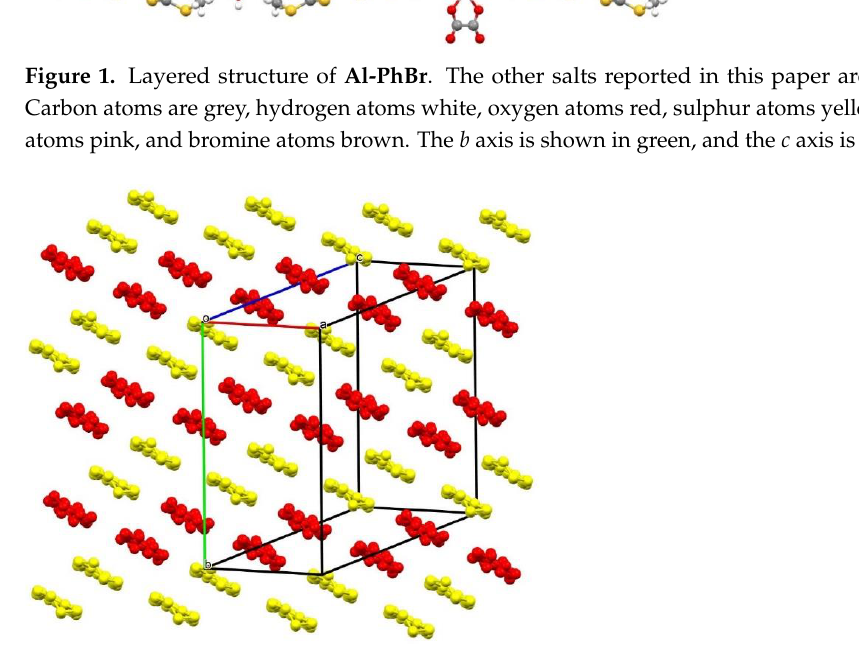
Figure 2. β ” BEDT-TTF layer packing in Al-PhBr. The other salts reported in this paper are isostruc- tural. The two crystallographically independent BEDT-TTF molecules are shown in different colours. Hydrogens have been removed for clarity. The a axis is shown in red, the b axis in green, and the c axis in